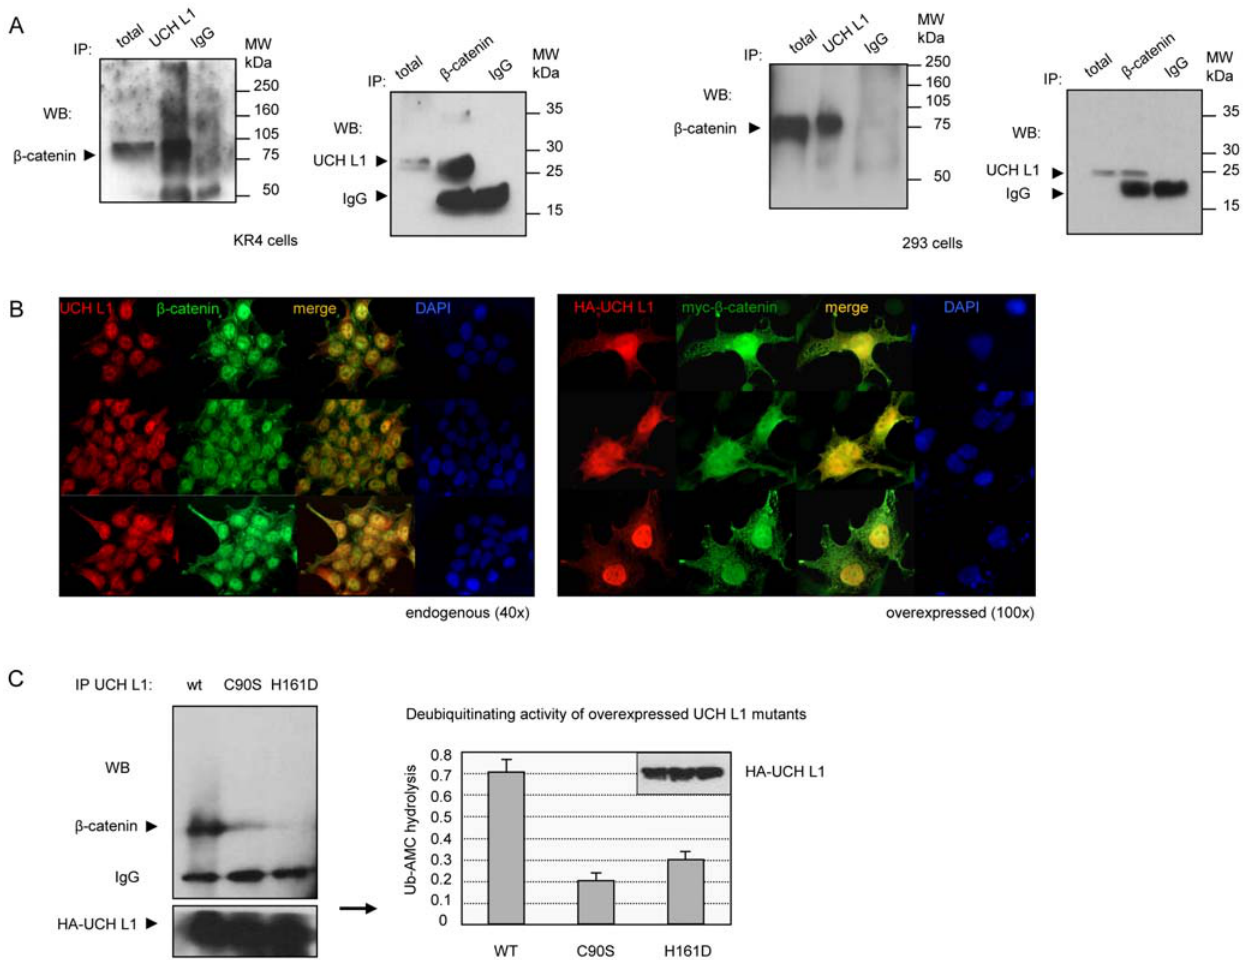
Figure 1. UCH L1 is physically associated with b -catenin. A. Endogenous b -catenin or UCH L1 were immunoprecipitated from KR4 (left) and 293 (right) cells. IPs were resolved in 10–12% PAGE and probed with indicated antibodies. Mouse and rabbit normal immunoglobulins were used as controls for IPs. B. Left panel: nuclear co-localization of UCH L1 and b -catenin. 293 cells were fixed in 4% PFA and double-immunostained with UCH L1 and b -catenin antibodies and red and green fluorescent secondary antibodies. Right panel: 293 cells were transfected with wild type HA-UCH L1 and myc- b -catenin expression vectors. After 24 h cells were fixed and probed with HA and myc antibodies. C. b -catenin is associated with wild type UCH L1, but not with inactive UCH L1 mutants. 293 cells were transfected with wild type and HA-UCH L1 mutants C90S and H161D, and UCH L1 was immunoprecipitated with HA antibody 48 h after transfection. IPs were resolved in 12% PAGE, transferred to PVDF membrane and probed with b - catenin antibody. Enzymatic activity of UCH L1 mutants was verified by in vitro hydrolysis of Ub-AMC (right